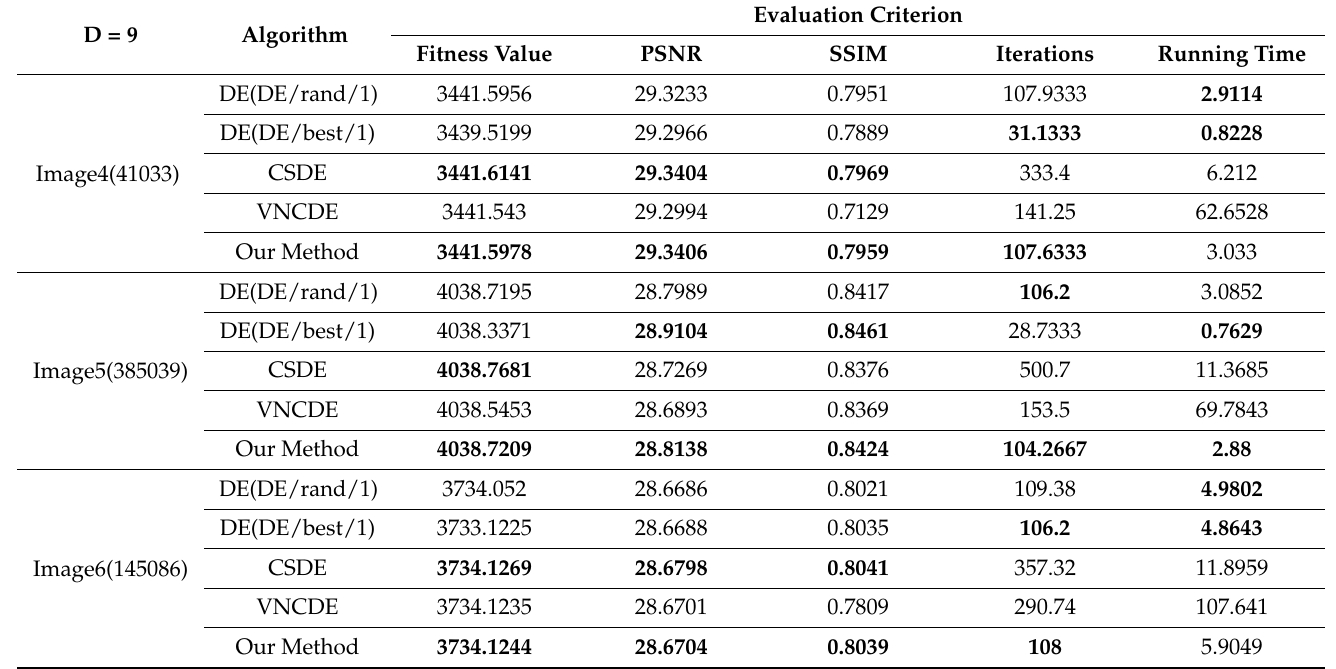
Table 5. Results comparison of five algorithms for segmentation of images 4–6 on different criteria when D =